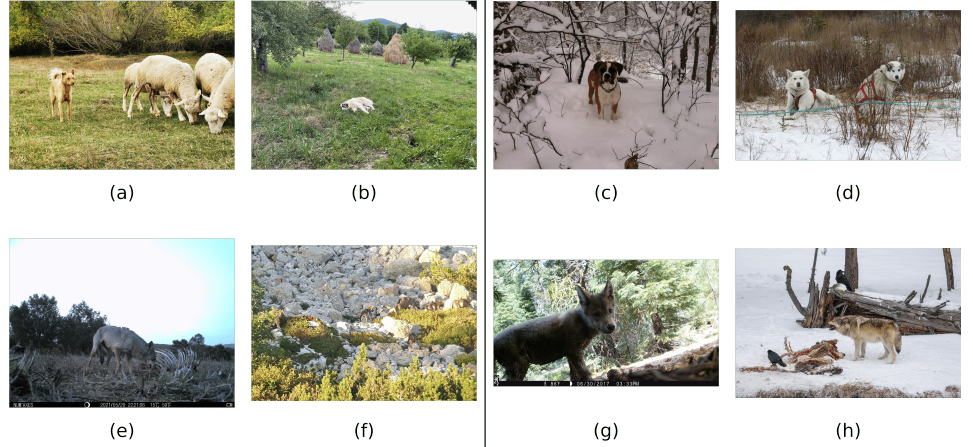
Figure 4. Samples of dogs ( upper row ) and wolves ( bottom row ) in Europe ( left ) and the rest of the world ( right ).